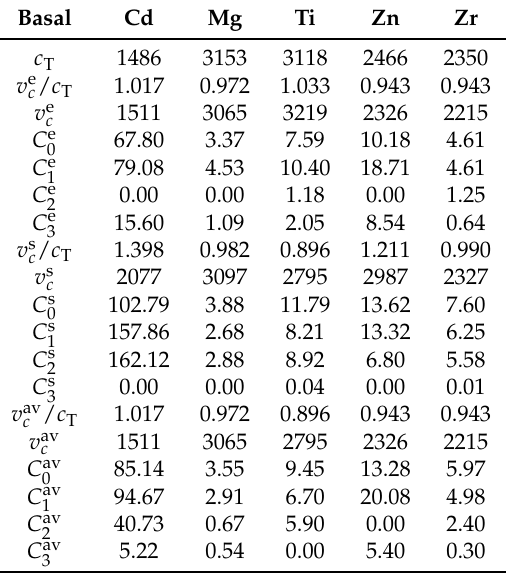
Table 4. List of critical velocities v c (m/s), and fitting function coefficients C i ( µ Pas) for basal slip. The critical velocities are given in units of m/s as well as in ratio to c T . The fits are only valid up to 0.99 c T and do not capture the asymptotic behavior for those metals/dislocations whose critical velocity is larger than this value. Superscripts “e”, “s”, and “av” refer to “edge”, “screw”, and “average”, respectively. Furthermore, v av c coincides with the smallest critical velocity for all dislocation characters ϑ within the basal slip